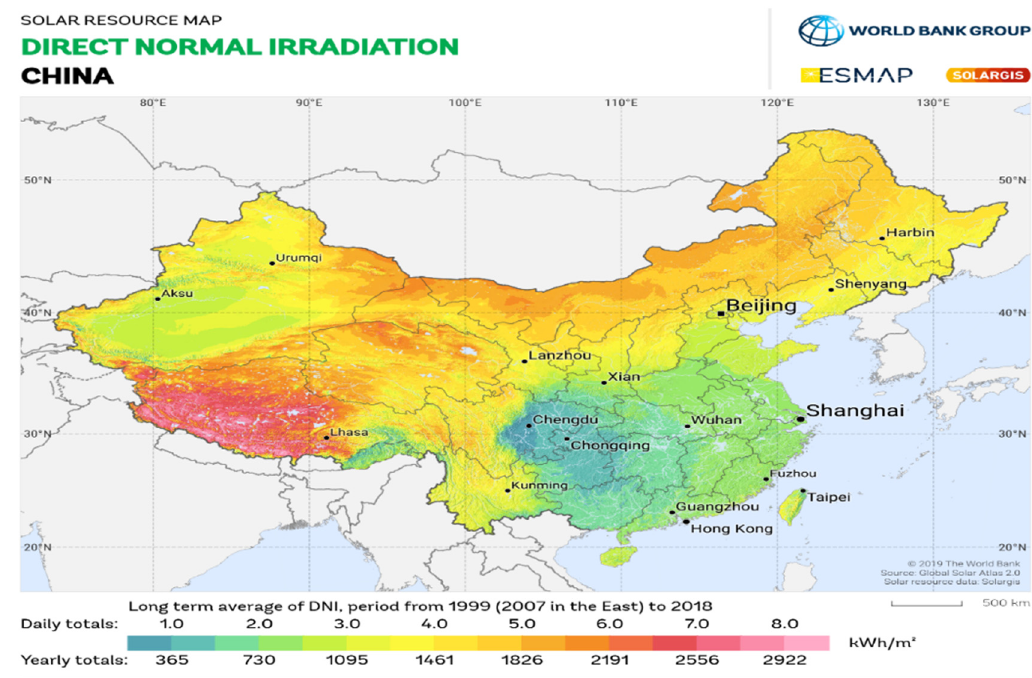
Energies 2021 , 14 , x FOR PEER REVIEW